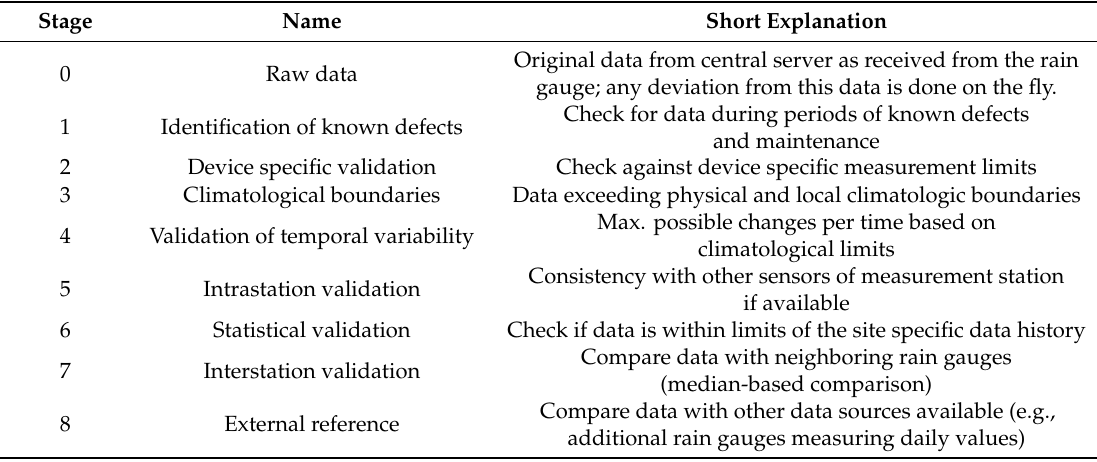
Table 3. Data validation